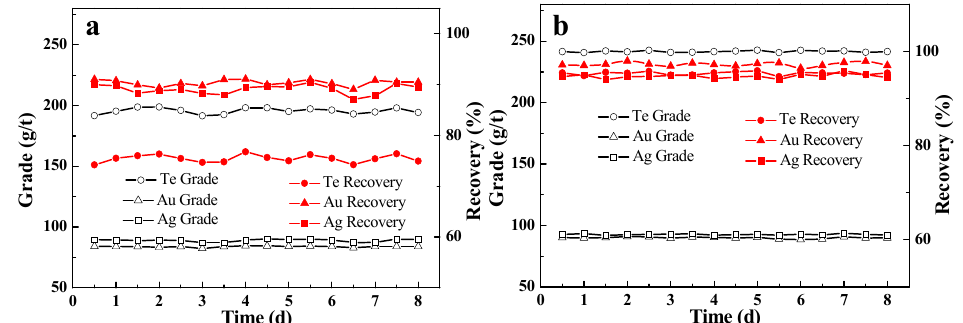
Figure 8. ( a ) Production data obtained from the operation site of a 300 t / d concentrator in Xiaoqinling: content of − 0.074 mm (66%); CaO adjusts pulp pH: 9; collector: sodium isoamyl xanthate 90 g / t; roughing pulp density: 33%; ( b )The 300 t / d Industrial test results after optimization of process conditions: roughing